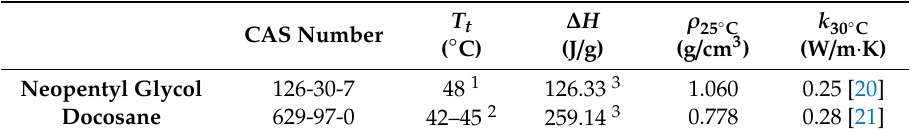
Table 1. Main properties of Neopentyl Glycol (NPG) and